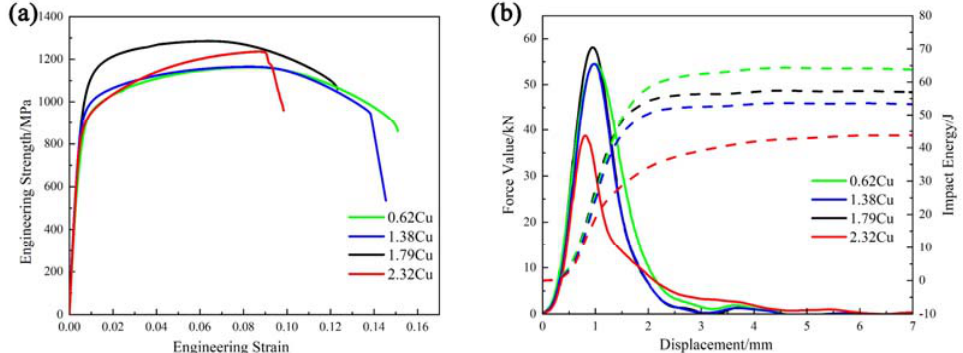
Figure 8. Mechanical properties of deposited metals. ( a ) Engineering strength-strain curves. The Cu 1.79 obtains the maximum strength value. ( b ) The Charpy V-Notch impact load curves (solid lines) and impact energy curves (dotted lines). Table 3. Crack initiation energy (Ei) and crack propagation energy (Ep) of deposited metals.